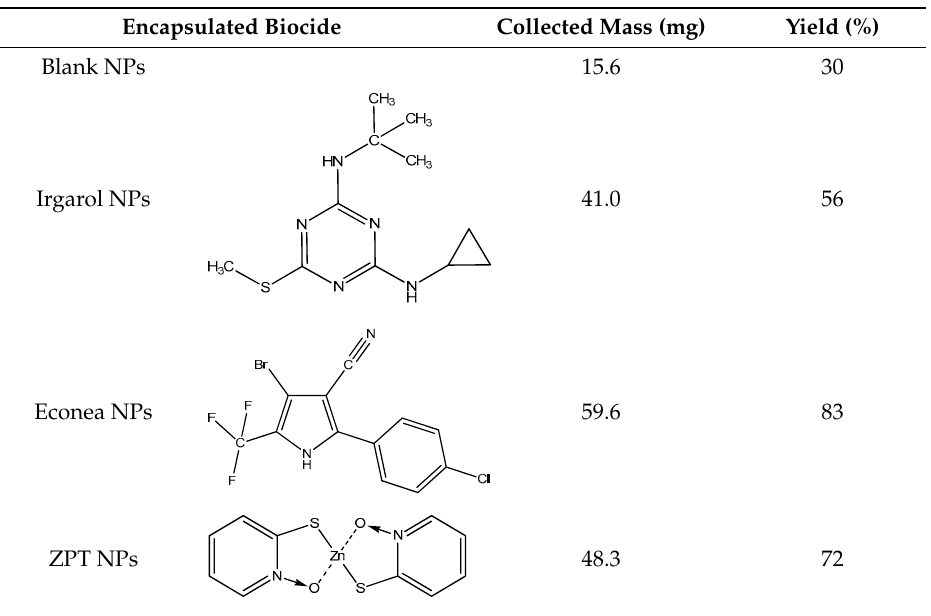
Table 2. Measured yield values (Yd) of the encapsulation process agents.